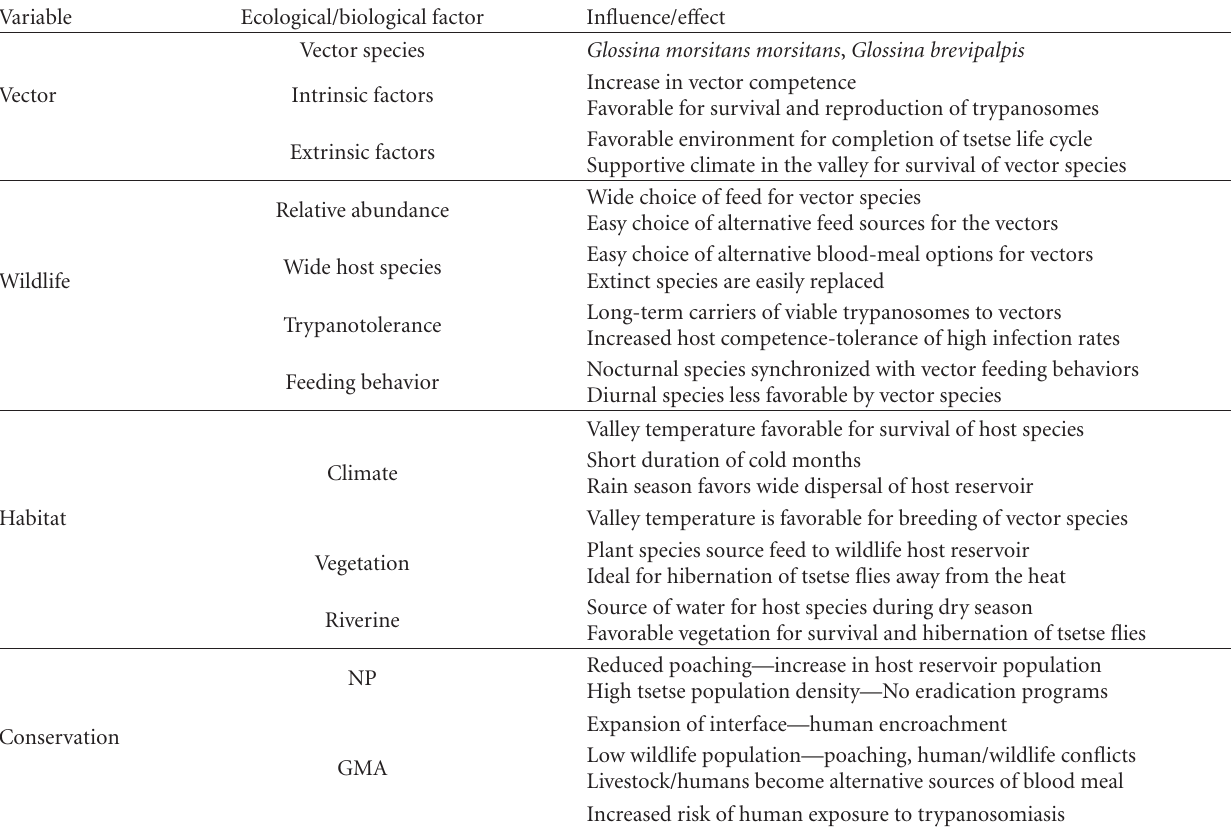
Table 4: Ecological and biological factors influencing the epidemiology